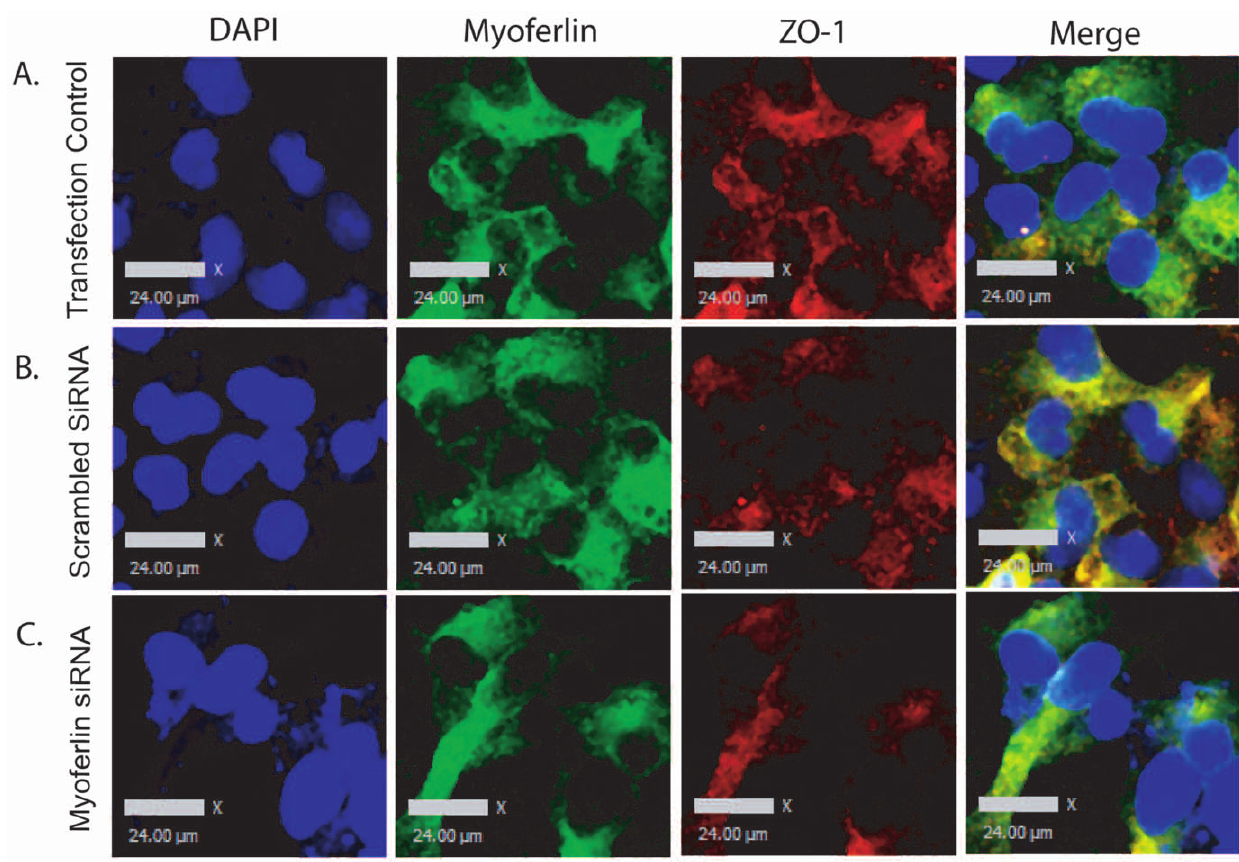
Figure 8. Co-localization of myoferlin and ZO-1. 16HBE cells were grown on 8 well chamber slides and treated with (A) transfection control, (B) scrambled siRNA, or (C) myoferlin siRNA both at 75 nM concentration for 72 h then fixed for immunofluorescence analysis. Immunofluorescent staining for myoferlin ( green ), zonula occludens 1 ( red ) and nuclei stained with 4 9 ,6-diamidino-2-phenylindole ( blue ); were used to examine the localization of ZO-1 and myoferlin following siRNA treatments. Scale bars are equal to 24 m m on all images.